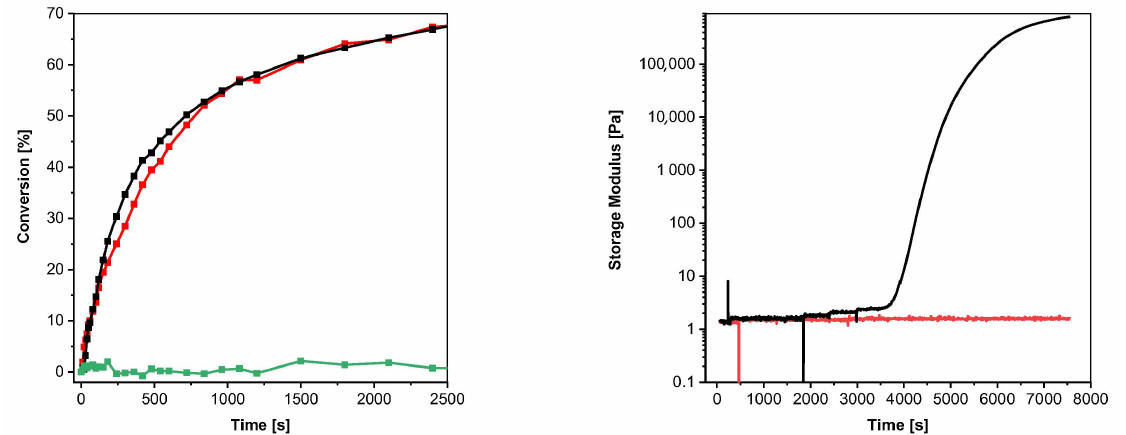
Figure 5. ( Left ): conversion of the acrylate groups of TMPTMA in a TMPTMA/PETMP formula- tion under UV illumination (red line with squares: 0.14 wt% (1 mM) 2b , black line with squares: 0.10 wt% (1 mM) 2a , green line with squares: without PI; 405 nm, 19.15 mW cm − 2 ). ( Right ): results of rheological measurements (black line: TMPTMA/PETMP with 0.10 wt% (1 mM) 2a ; red line: TMPTMA/PETMP with 0.14 wt% (1 mM) 2b ).